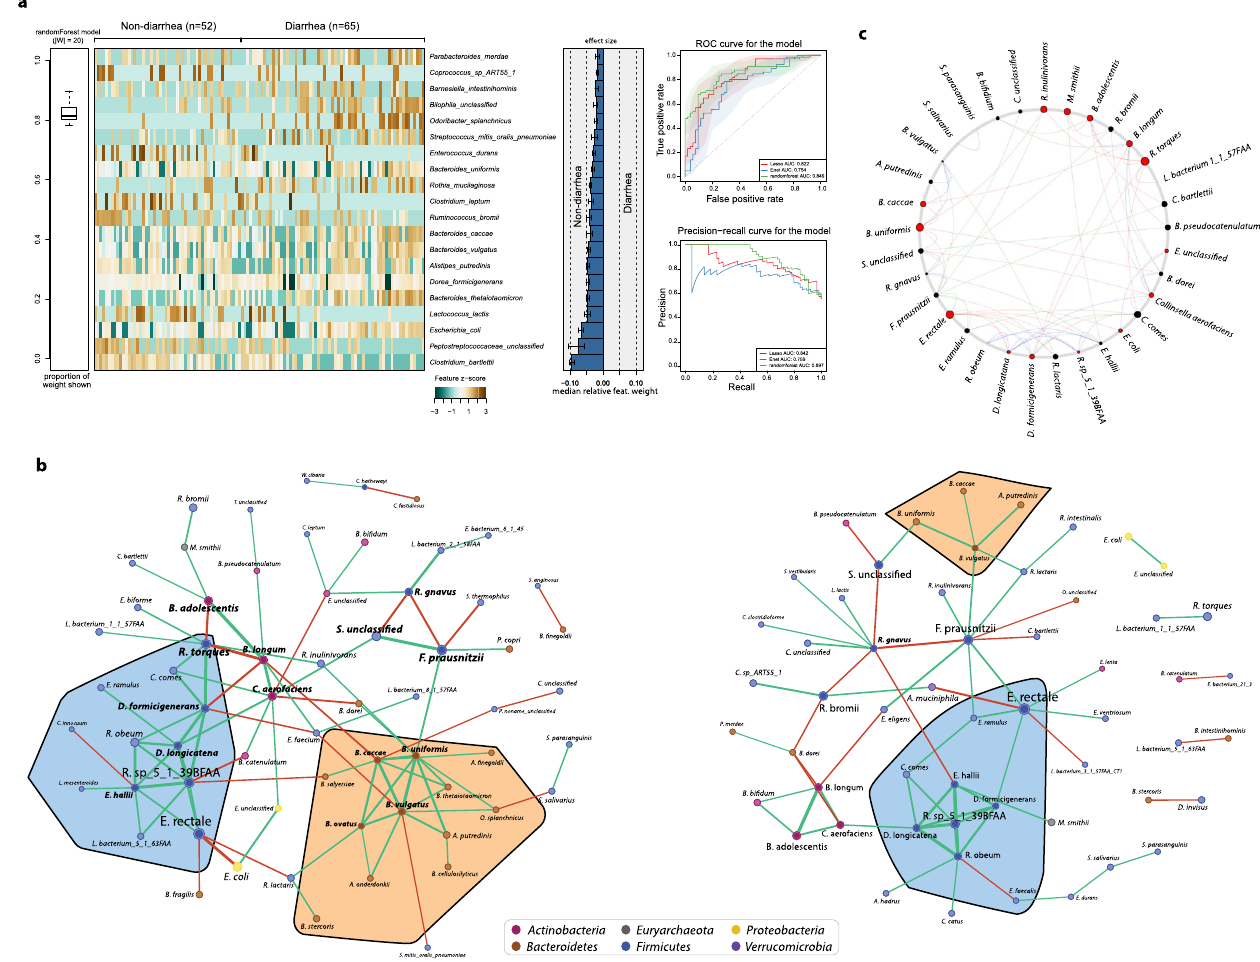
Fig. 3 | Development of machine learning classi fi er that uses species abun- dancestodistinguishbetweendiarrhealandnon-diarrhealsampletypes.a The heatmap showing the relative abundances of top 20 discriminatory taxa between diarrheal and non-diarrheal PreTD types. Barplot depicts the effect size of the discriminatory taxa obtained from Random forest model. Cross-validation accu- racy depicted as AUC-ROC and Precision-recall curve for the models built with three independent methods: ElasticNet (blue), Lasso (red) and Random Forest (green). b Co-occurrence network of diarrheal (left) and non-diarrheal (right) samples. The sizes of the nodes are proportional to the mean relative abundances of the species. The edges between two nodes represent signi fi cant correlations (green: positive; red: negative) between the two species. The orange highlighted